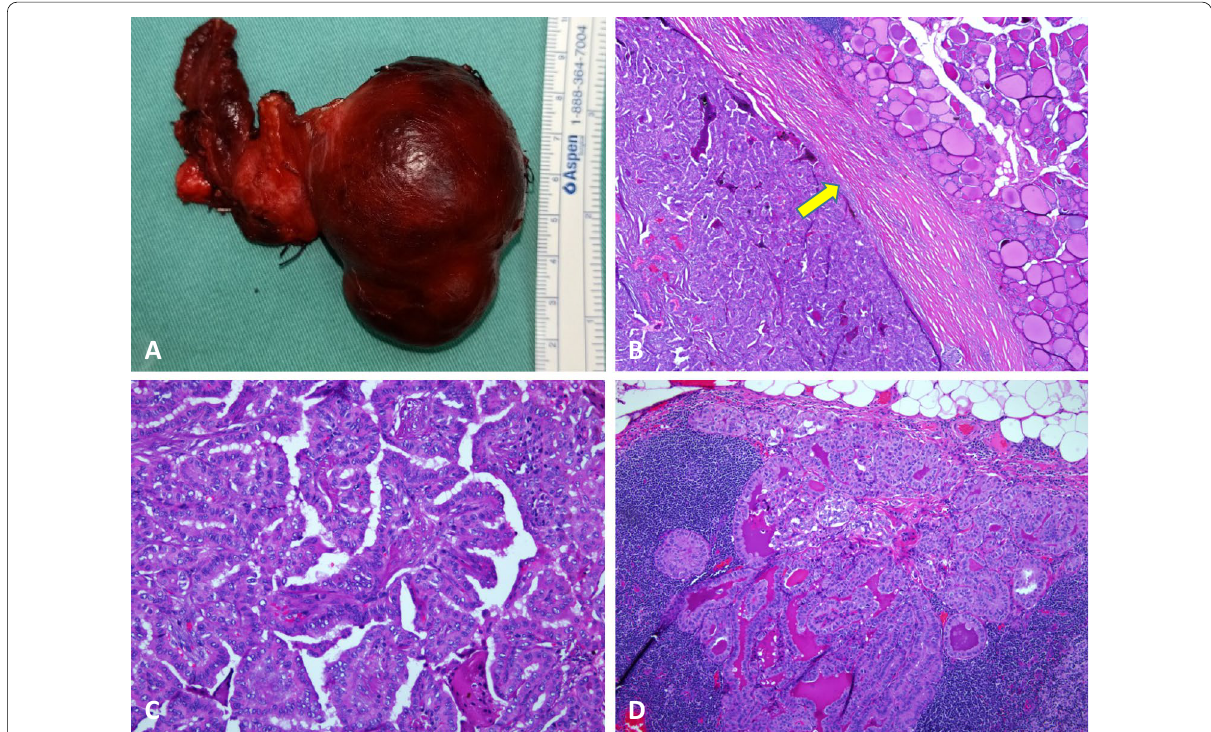
Fig. 2 Histopathological examination. a A total thyroidectomy with nodular appearance. b Section from the right thyroid shows a well-demarcated tumour area with partly encapsulated (arrow) exhibiting tumour in papillary patterns. (H&E, of papillary thyroid carcinoma showing papillae with fibrovascular core, nuclear clearing and grooving.